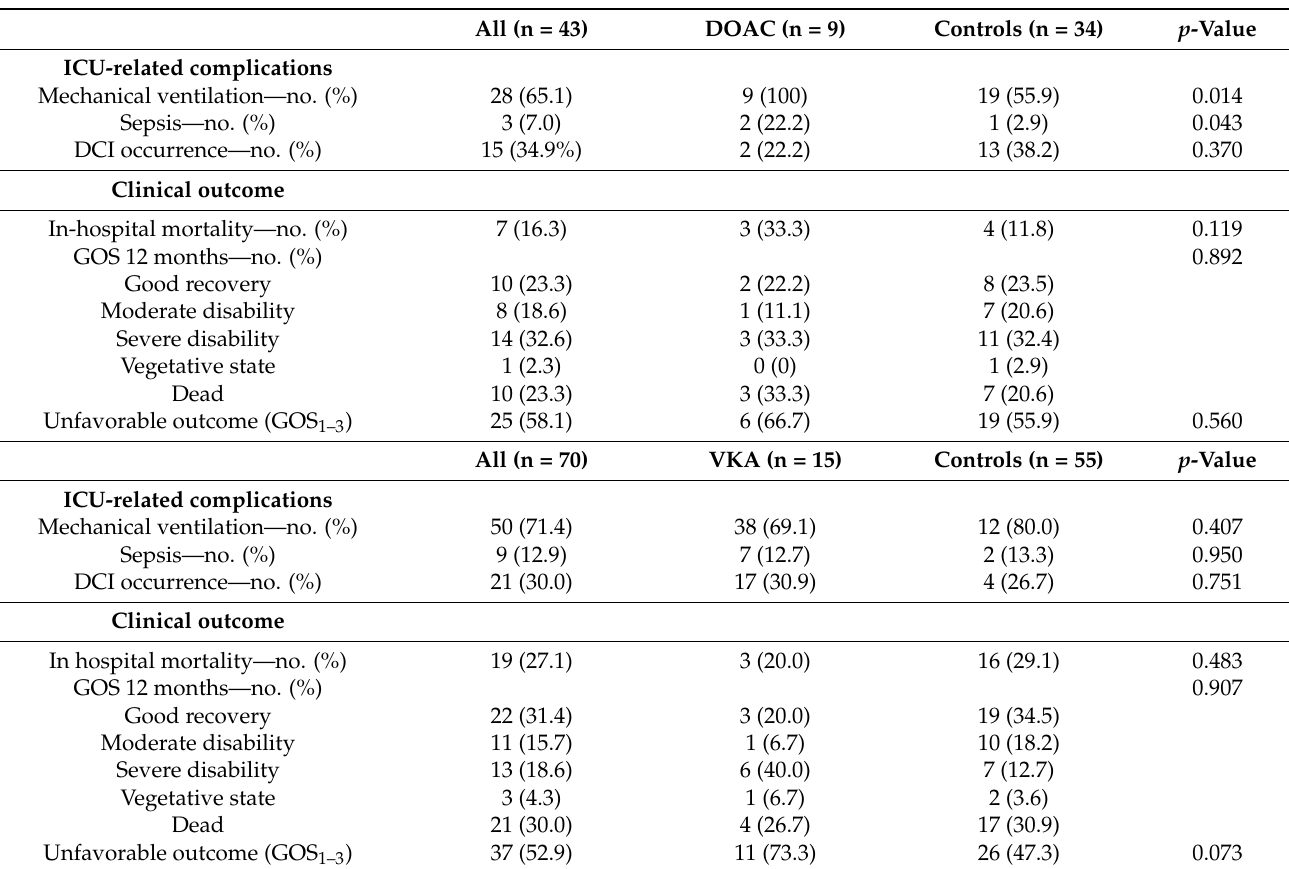
Table 3. Outcome comparison of patients on either direct oral anticoagulants (DOAC) or vitamin K antagonists (VKA) with age- and sex-matched controls without antithrombotic treatment. All (n =